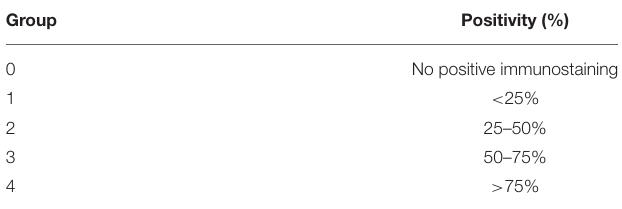
TABLE 2 | Classification: percentage of tumor cells showing cytoplasmic positivity.